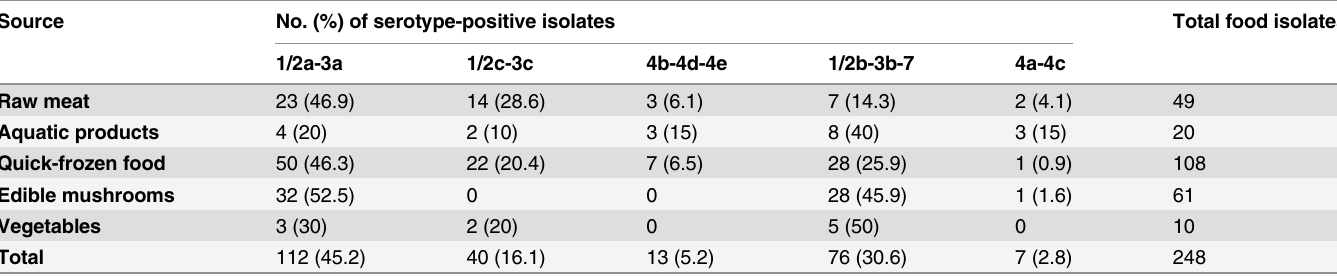
Table 4. Serogroups of Listeria monocytogenes strains in positive samples.